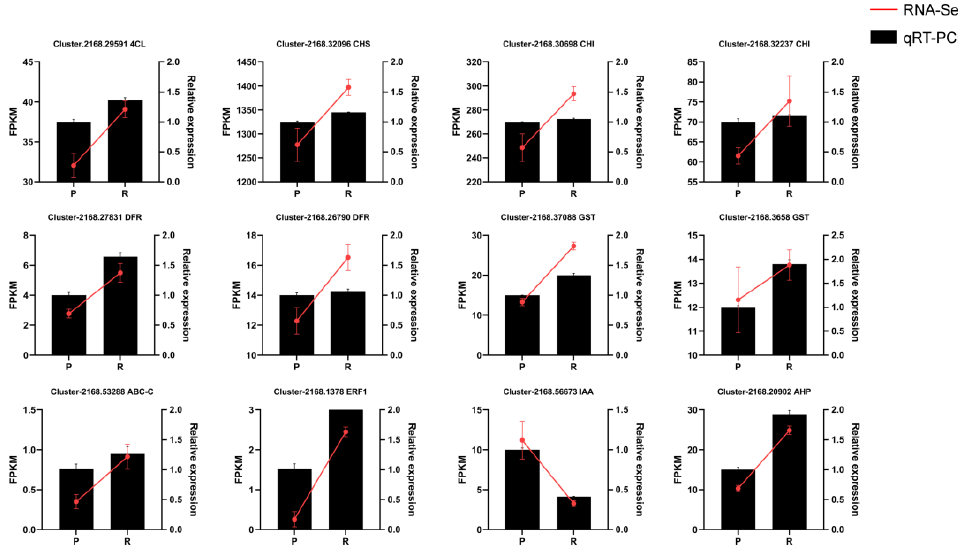
Figure 5. qRT-PCR analysis of the expression levels of DEGs in samples from pink (P) and red (R) petal regions. Data are presented as mean ± SE of three independent replicates.